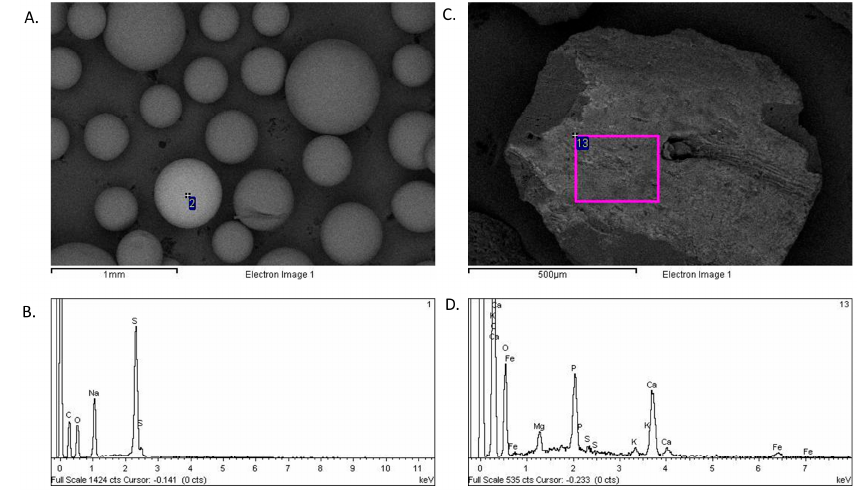
Figure 5. Electron microscopy images of water purification components. ( A ) Image and ( B ) composition of the ion exchange resin. ( C ) Image and ( D ) composition of activated carbon.